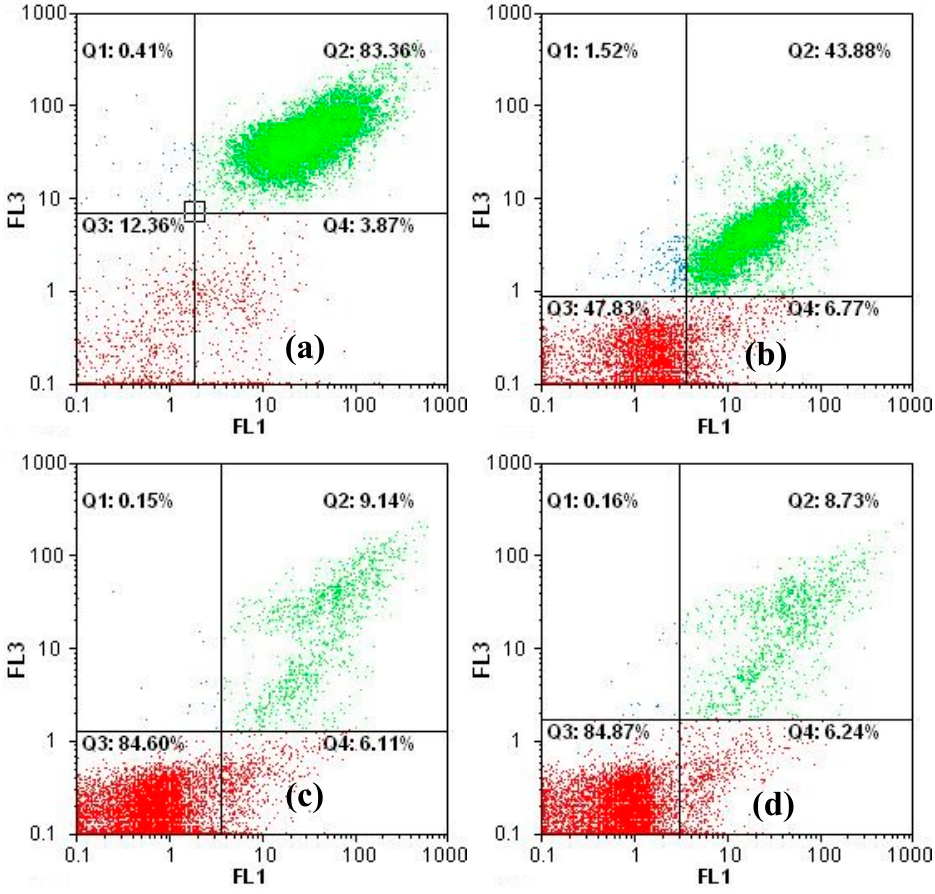
Figure 7. Flow cytometry images of Microcystis aeruginosa cells by FL1 (505–535 nm) and FL3 (565–605 nm) detectors. Ag-TiO 2 /DM dosage (mg/L): ( a ) 0, ( b ) 520, ( c ) 1050, and ( d ) 2100.